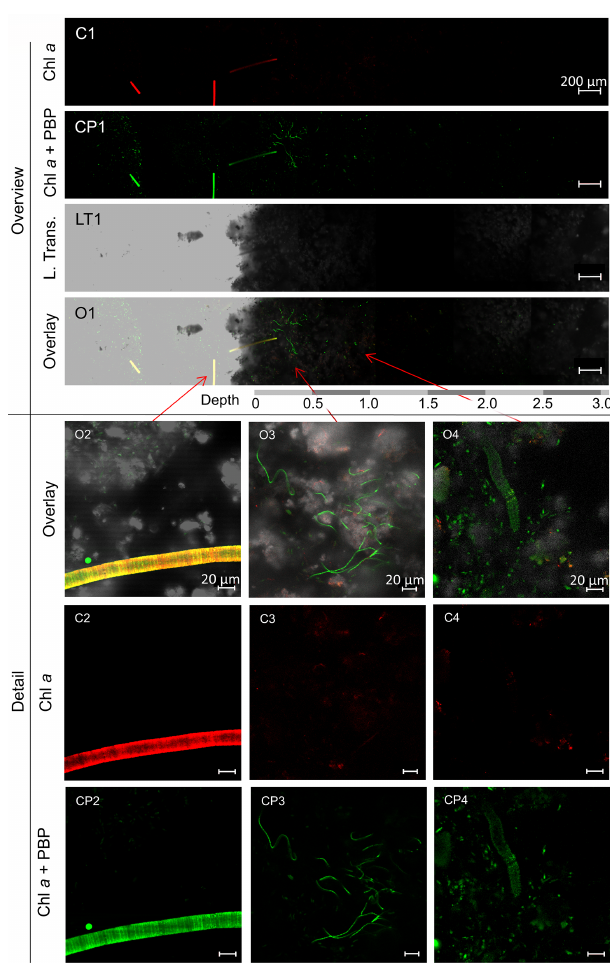
Figure 2. CLSM images of mat sample E4.1. Overview: images of the cross-section of the top 3mm of the biofilm with the Chl a (C1) and Chl a plus PBP (CP1) fluorescence profile, complemented by a laser transmission picture (LT1) and the superimposed image (O1). Detail: superimposed images (O2, O3, O4) of Chl a (C2, C3, C4) and Chl a plus PBP (CP2, CP3, CP4) fluorescence and laser transmission (not shown) of distinct organisms found in the bio